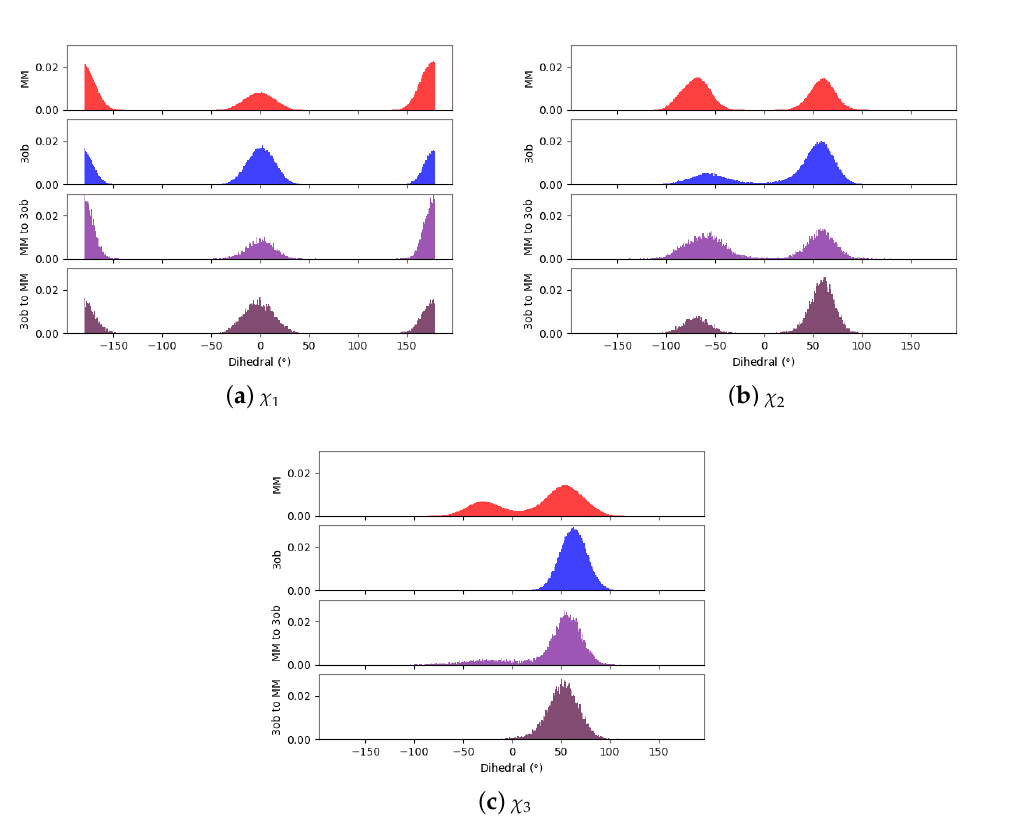
Figure 5. Dihedral populations for 11 ’s dihedral degrees of freedom (see Figure 2 for dihedral